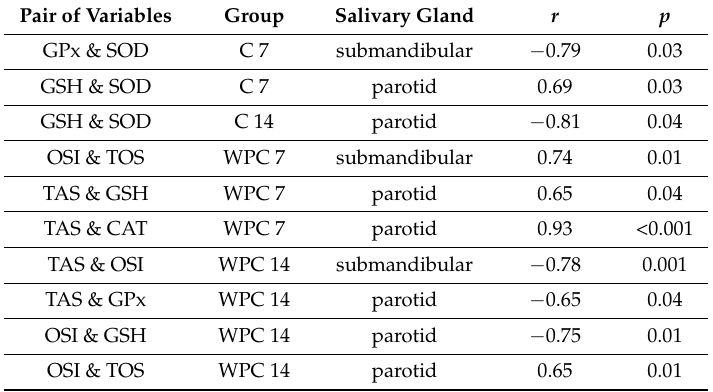
Table 4. Correlations between analyzed redox parameters in the submandibular and parotid glands of rats from control and experimental groups. Abbreviations: C7, C14, control groups; WPC7, WPC14, experimental groups treated WPC-80; CAT, catalase; GPx, glutathione peroxidase; GSH, reduced glutathione; SOD, superoxide dismutase; TAS, total antioxidant status; TOS, total oxidant status; OSI, oxidative stress index. Pair of Variables Group Salivary Gland